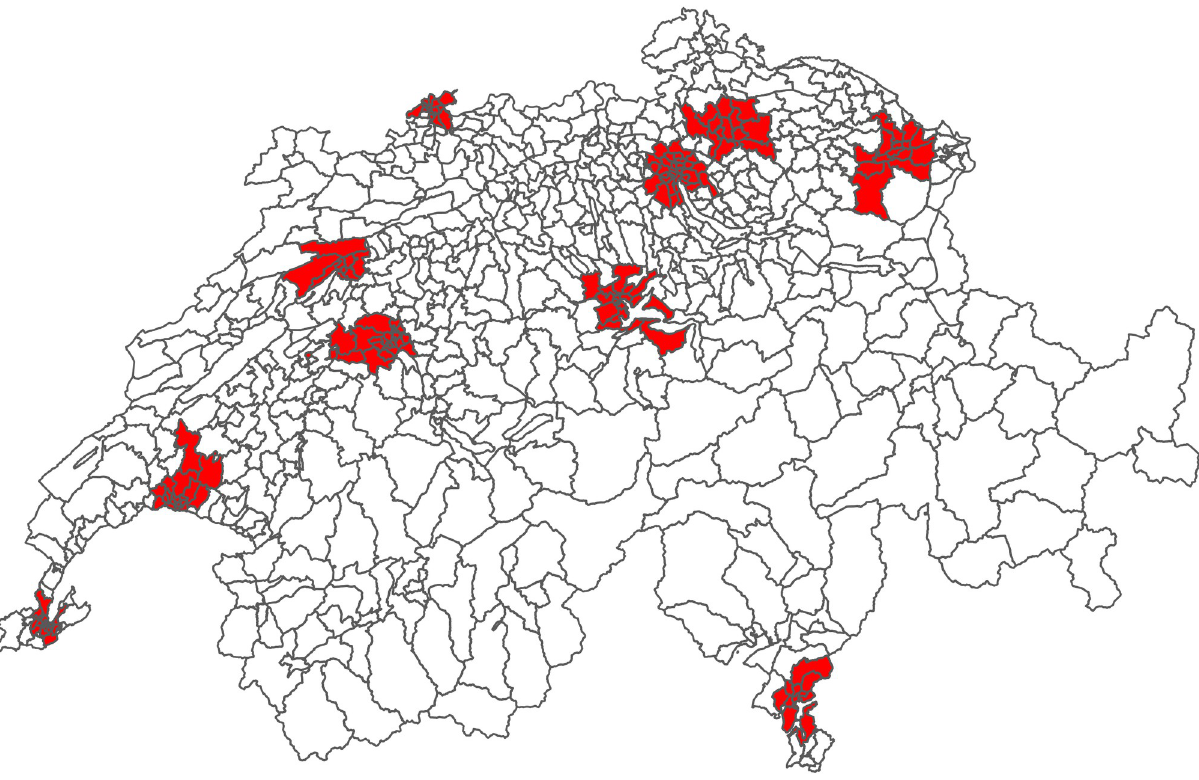
Fig 1. Assigned MedStat regions for each